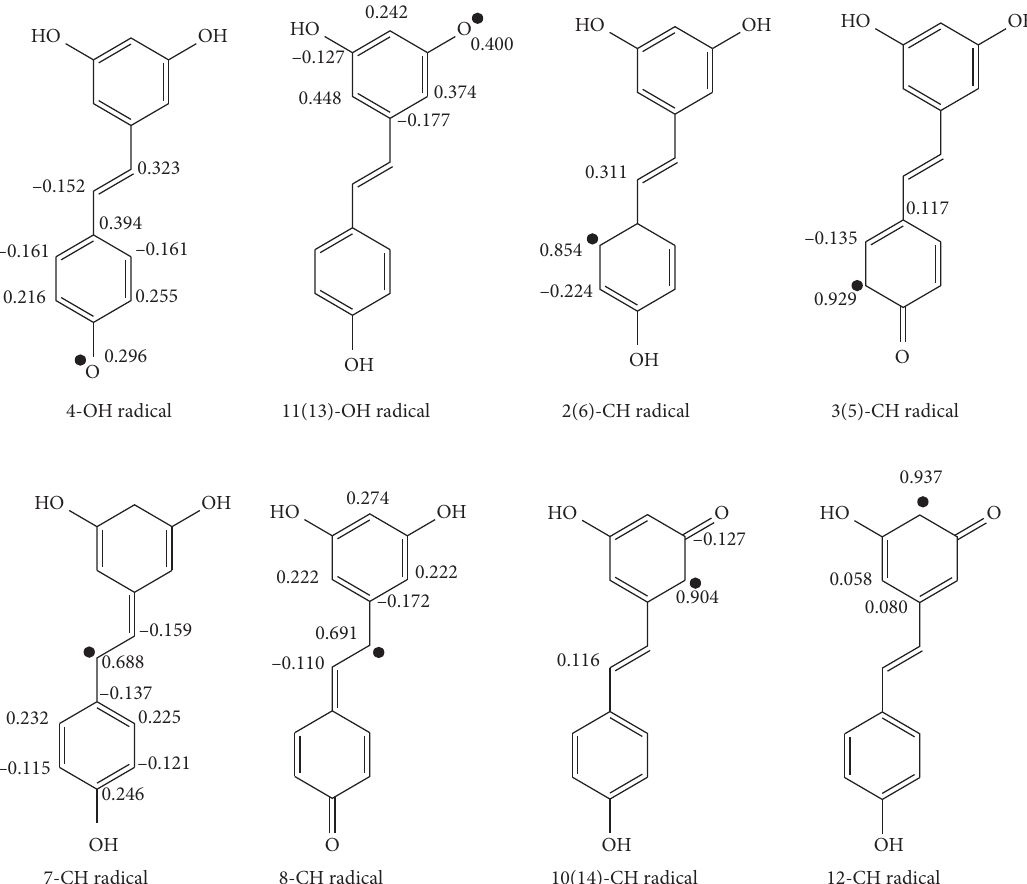
Figure 4: Spin density distribution of structural radicals in the gaseous medium at B3LYP/6-311++G(d, p) level of